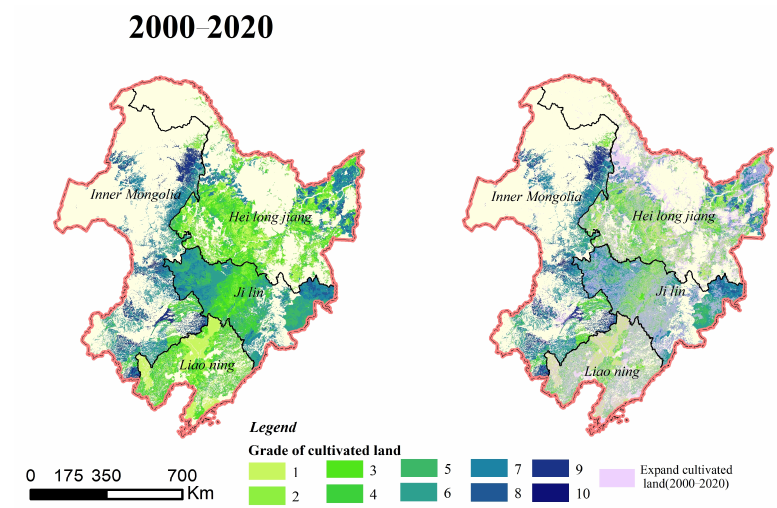
Figure 7. Grade map of cultivated land in Northeast China.